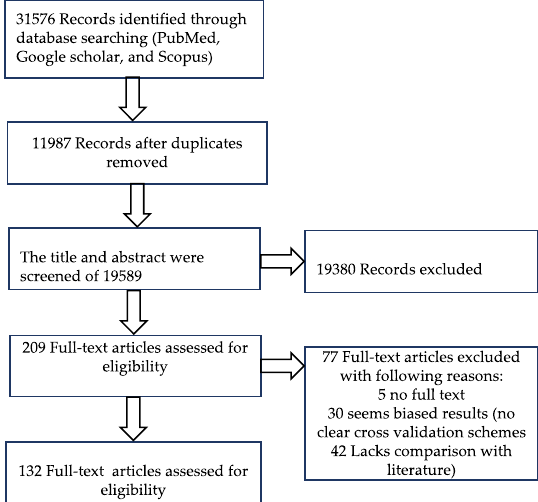
Figure 2. Criteria for literature selection for systematic review according to preferred reporting items for systematic seviews and meta-analyses (PRISMA) [23] guidelines.